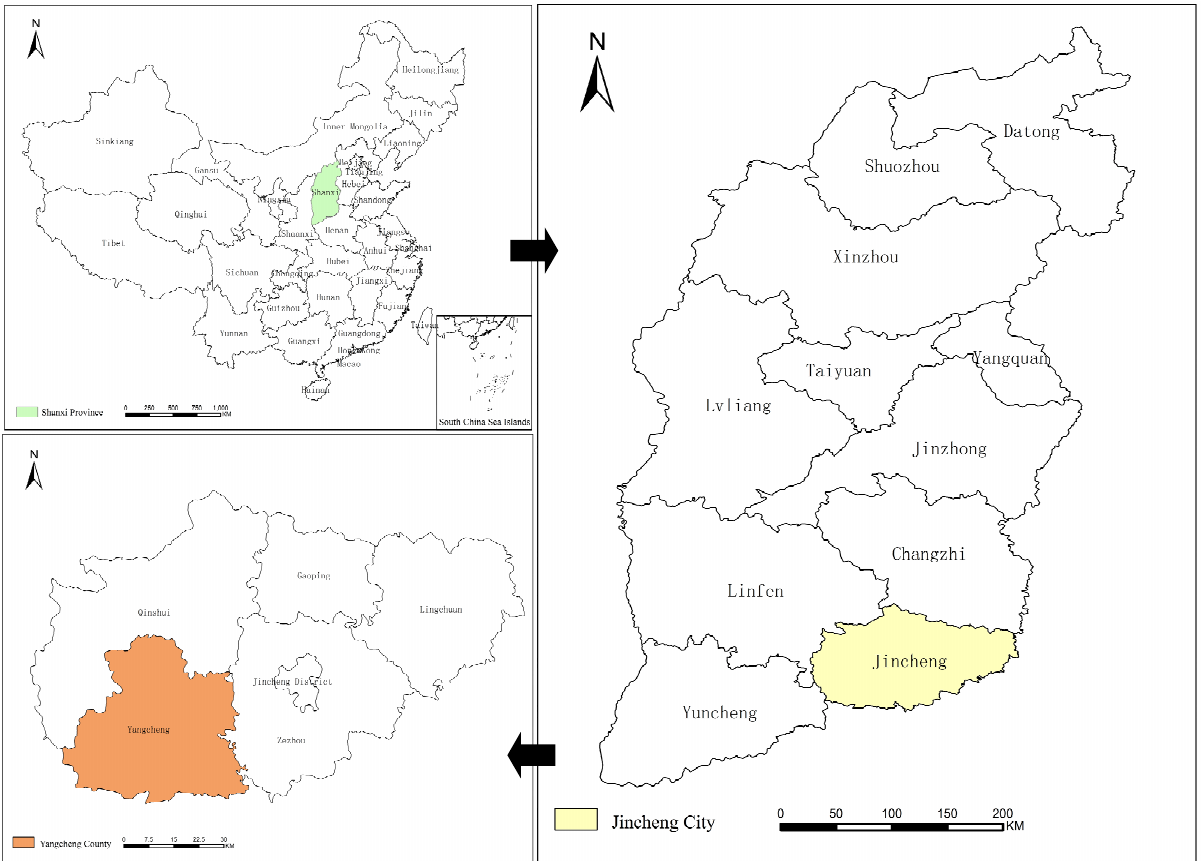
Figure 8. Study area: Yangcheng County, Jincheng City, Shanxi Province.